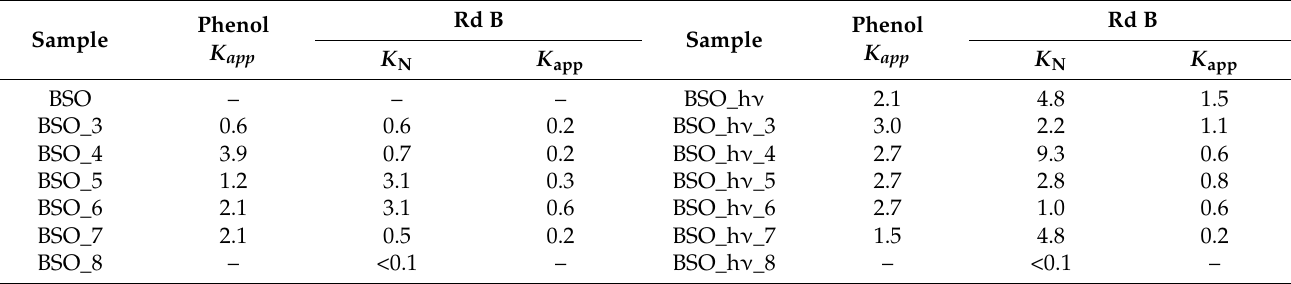
Table 2. Photodecomposition rate constants for phenol and Rd B in µ M/h.